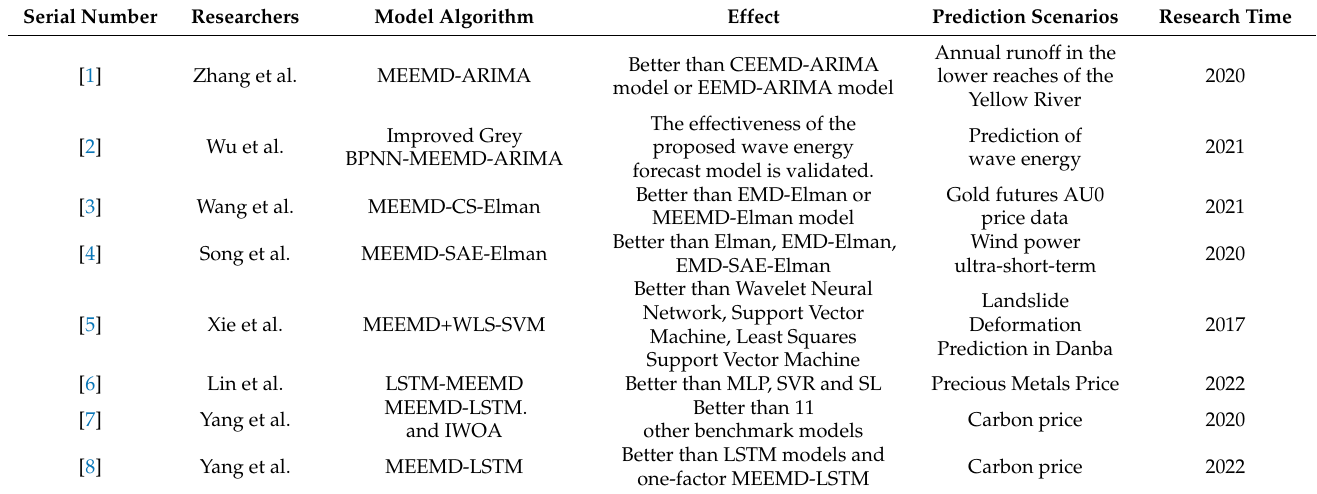
Table 1. Study of correlation portfolio prediction